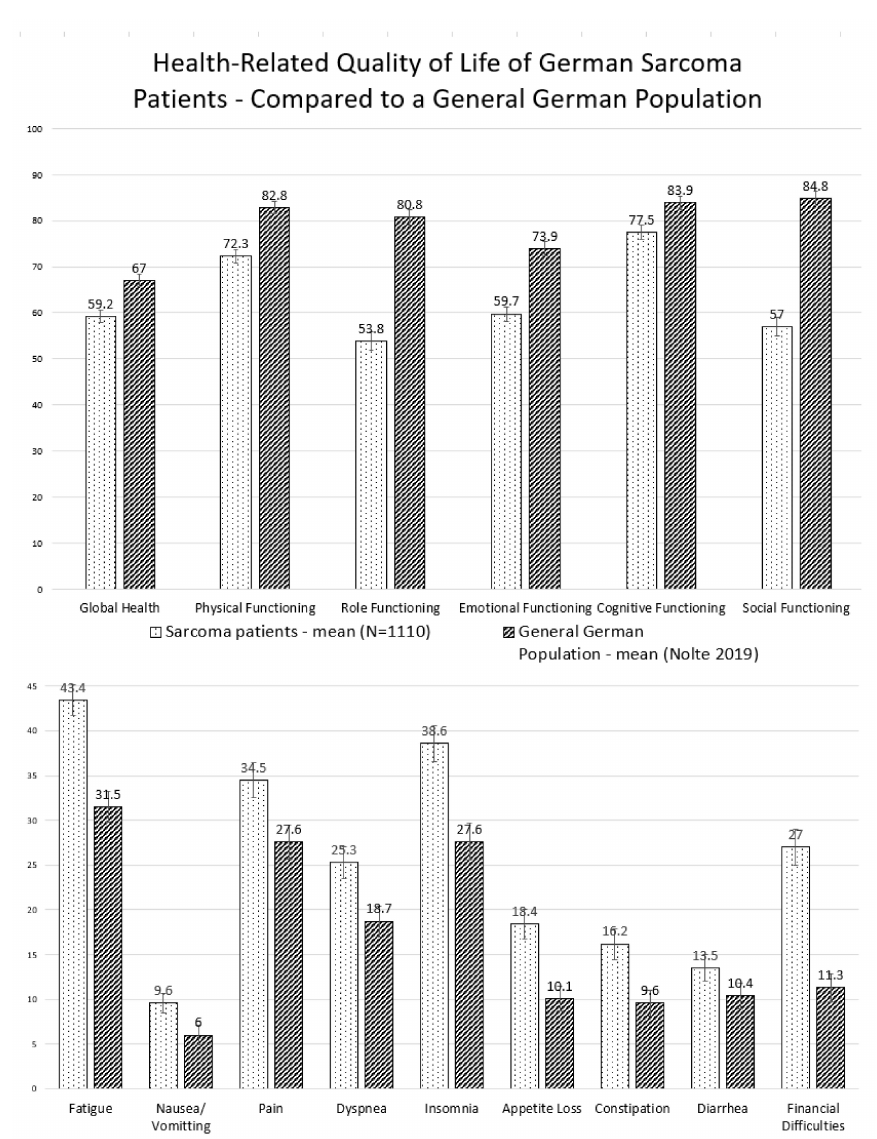
Figure 2. Age and gender standardized health-related quality of life of sarcoma patients and survivors. Mean values. Comparison with norm data from a German normal population (Nolte 2019). (cid:108) 95% confidence intervals. Large Di ff erences: Role Functioning, Social Functioning; Medium / Moderate Di ff erences: FinancialDi ffi culties, EmotionalFunctioning; SmallDi ff erences: Fatigue, Dyspnea, Physical Functioning, Cognitive Functioning, Nausea / Vomiting, Pain, Insomnia, Appetite Loss, Diarrhea, Global Health,